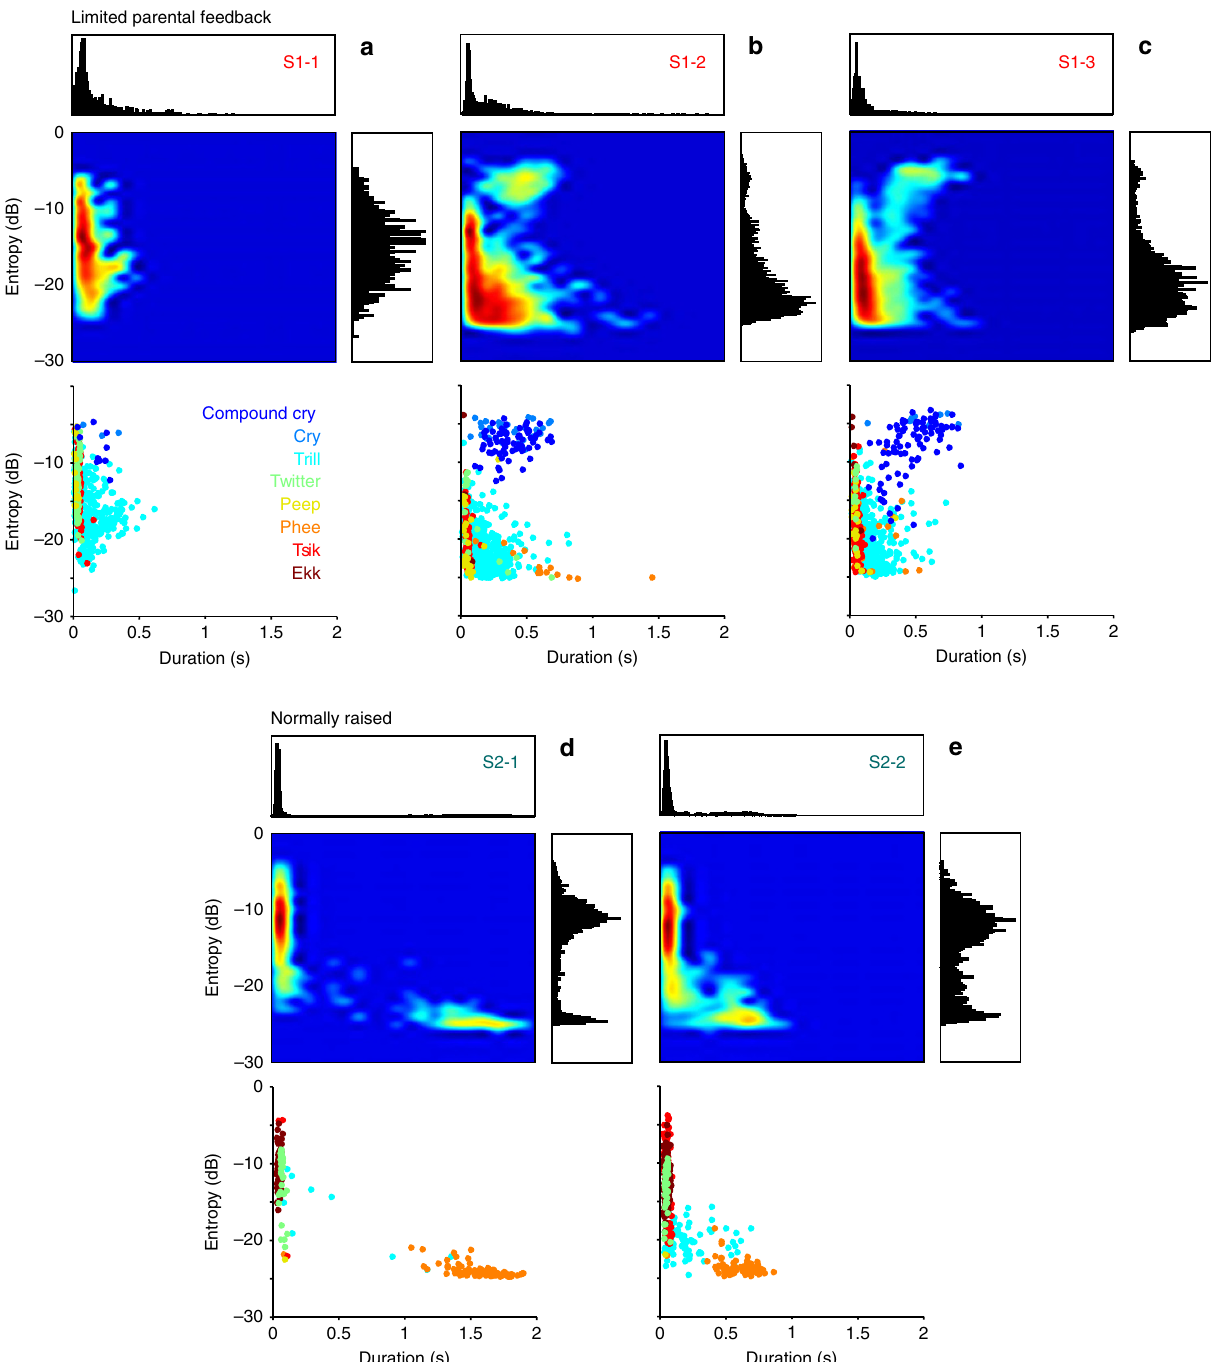
Figure 3 | Differences in call entropy and duration between S1 and S2 monkeys. Heat maps depict logarithmic probability maps of call entropy and duration for S1 ( a – c ) and S2 siblings ( d , e ; middle left panels). Warmer colours indicate higher probabilities. Histograms show absolute distribution of call entropy (middle right panels) and duration (upper panels). Raster plots show correspondence between clusters and call types for a single recording session each (lower